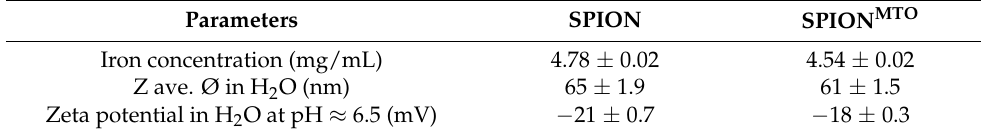
Table 1. Physicochemical characterization of superparamagnetic iron oxide nanoparticles. The hydrodynamic diameter and zeta potential of SPION and SPION MTO were determined in H 2 O. Abbreviations: SPION, superparamagnetic iron oxide nanoparticles; MTO, mitoxantrone; Z ave. Ø, mean